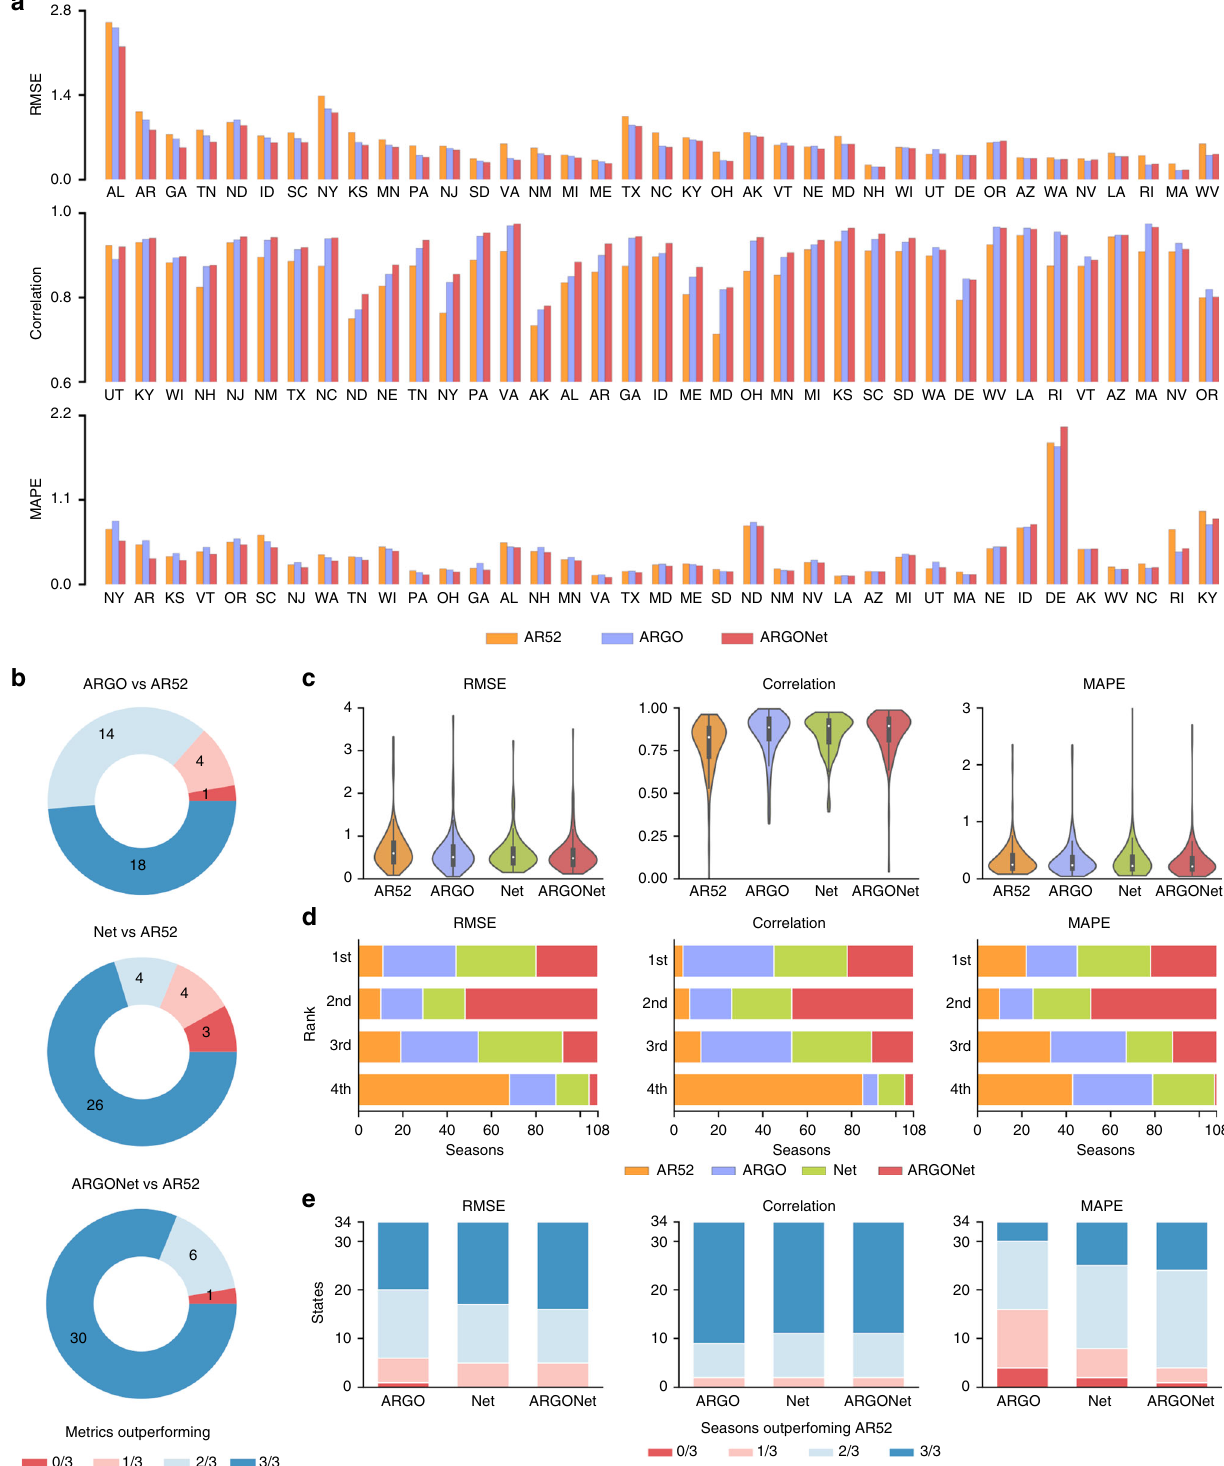
Fig. 3 Summary of ARGONet performance benchmarked with ARGO and AR52. a State-level performance of ARGONet with benchmarks, as measured by RMSE (top), Pearson correlation (middle), and MAPE (bottom), over the period from September 28, 2014 to May 14, 2017. States are ordered by ARGONet performance relative to the benchmarks to facilitate comparison. b The proportion of states where ARGO (top), Net (middle), or ARGONet (bottom) outperforms AR52 in 0, 1, 2, or all 3 metrics. c The distribution of values for each metric for each model, over the 108 state-seasons during the same period. The embedded boxplots indicate median and interquartile ranges. Numerical values are reported in Supplementary Table 1. d The distribution of ranks attained by each model over the 108 state-seasons for each metric. e The proportion of states where each model outperforms AR52 in 0, 1, 2, or all 3 in fl uenza seasons within the same period. Only 34 states have data for all three in fl uenza seasons available in this